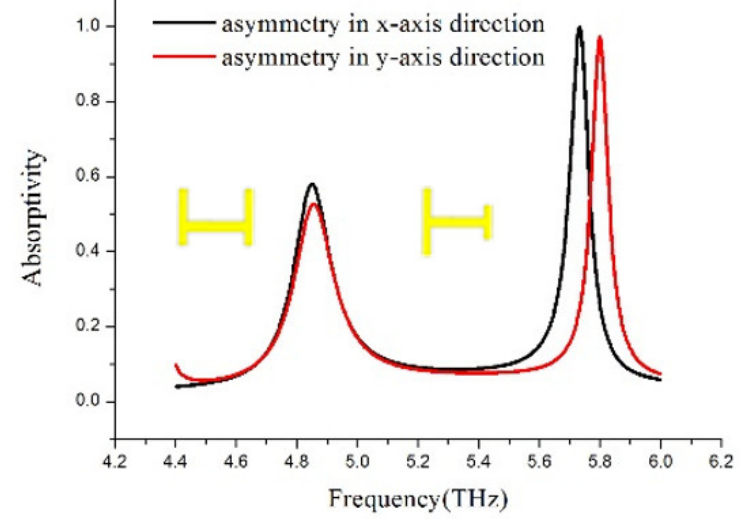
Figure 3. Absorption spectra for asymmetry in the H-shaped unit cell in the x-axis or in y-axis direction alone by changing the strips’ length with ∆ x = 9 µ m in the same directions depicted as the inset.